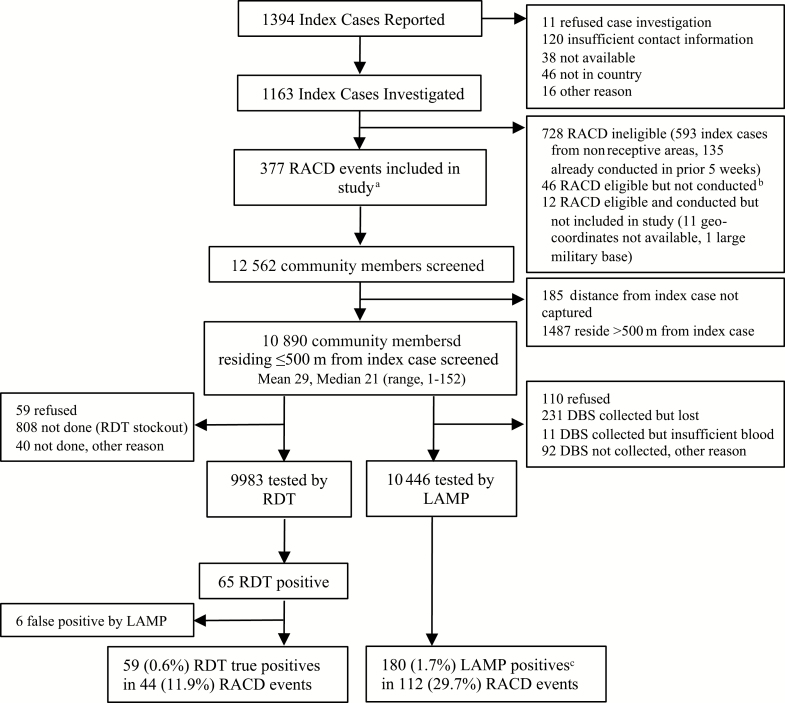
Schematic of reactive case detection (RACD) enrollment and rapid diagnostic test (RDT) vs loop-mediated isothermal amplification (LAMP) results. aOf 350 index cases for whom a DBS was available for confirmatory testing, 262 (74.9%) were confirmed by genus-specific LAMP testing (Pan-LAMP), of which 98.8% (252/255) were confirmed P. falciparum by Pf-LAMP testing. Of 88 LAMP-negative samples, 75% were not collected before treatment or could not be confirmed to have been collected before treatment. bOther reasons RACD not conducted: suspected false positive diagnosis in index case, timed out due to late case reporting or limited staffing, usual residence not in village. cOf these 180 Pan-LAMP positives, 157 (87.2%) were confirmed P. falciparum by Pf-LAMP testing. Abbreviations: DBS, dried blood spot; Pf-LAMP, P. falciparum loop-mediated isothermal amplification.